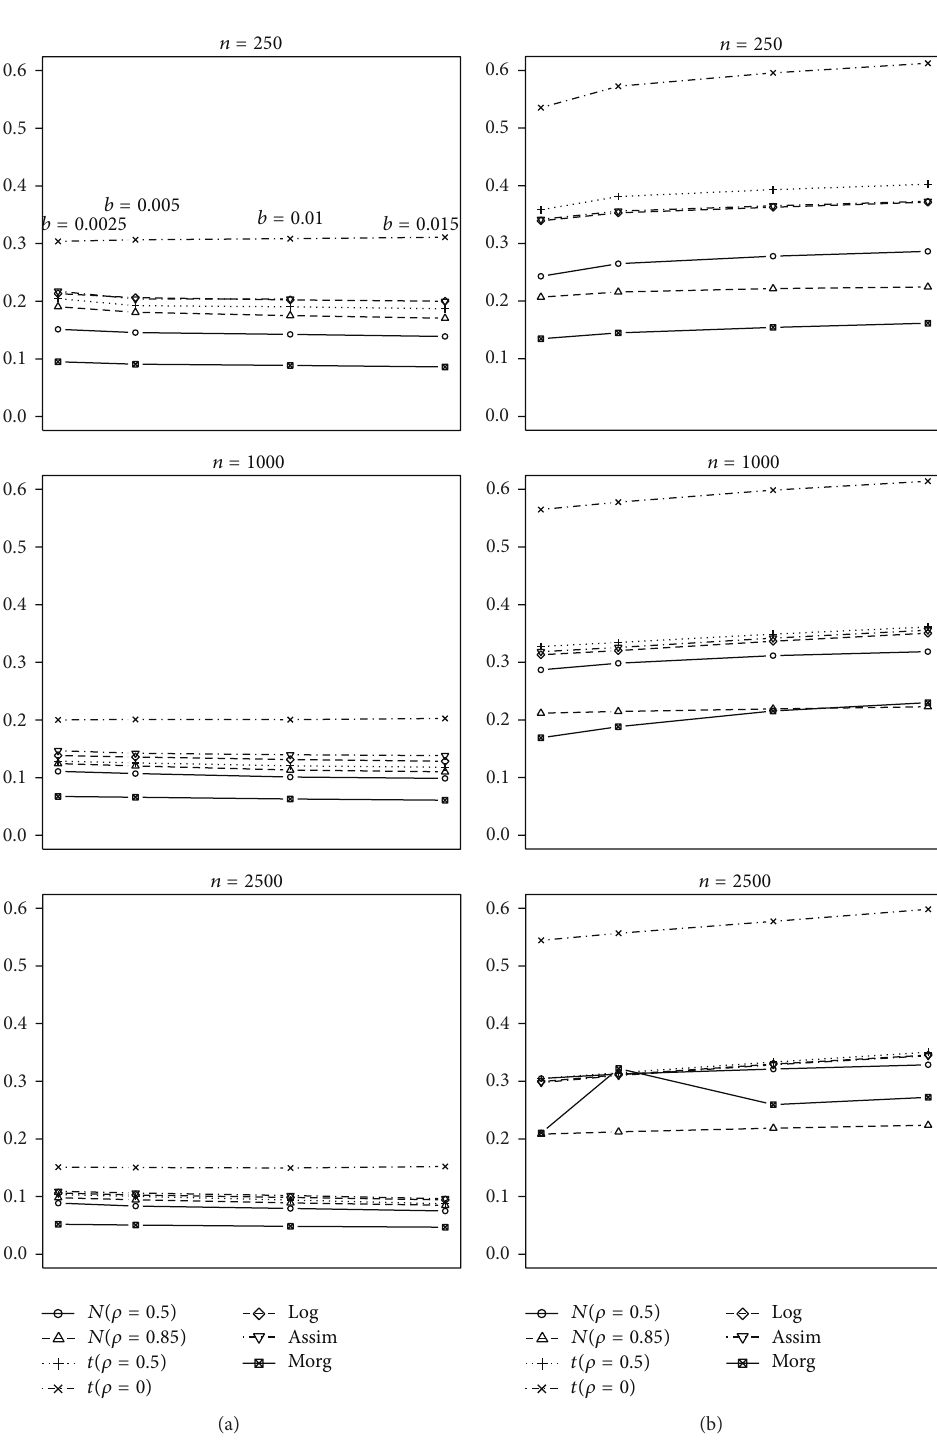
Figure 5: Root mean squared error (rmse) of estimator ̂𝜂 (a) and estimator 0.0025, 0.005, 0.01, 0.015 ,